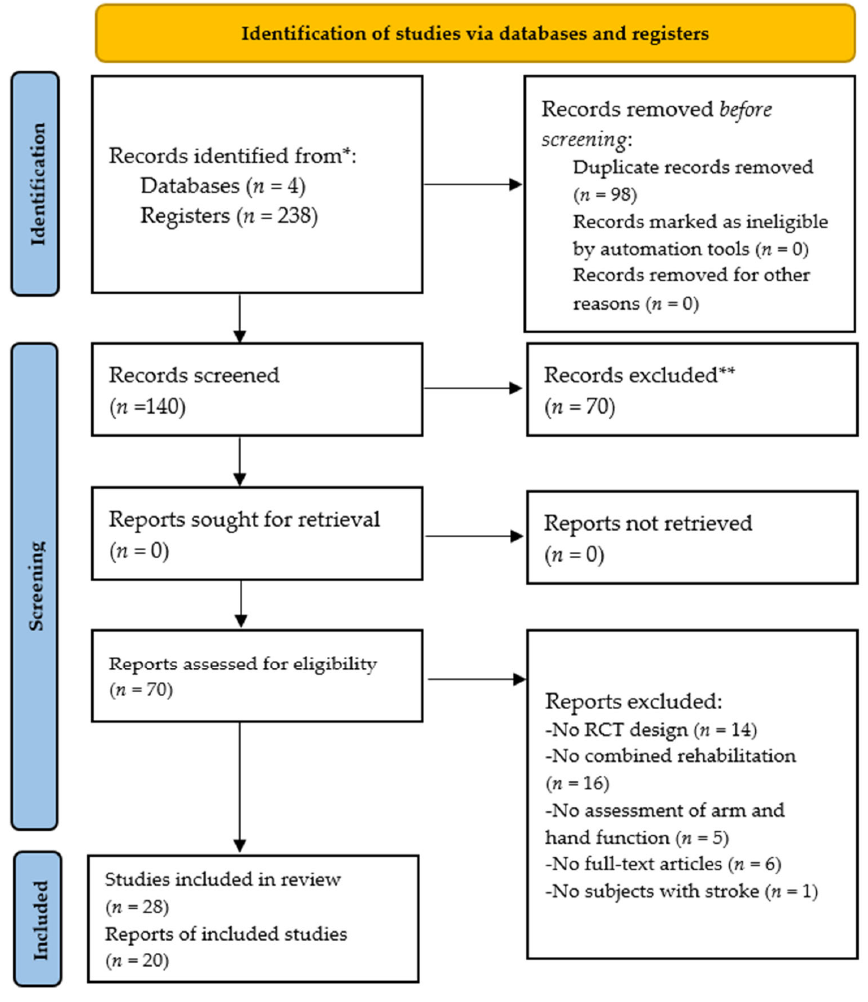
Figure 1. Preferred Reporting Items for Systematic Reviews and Meta-Analyses (PRISMA) 2020 flow diagram of study selection. *, record identification; **, record exclusion. RCT, randomized controlled trial.